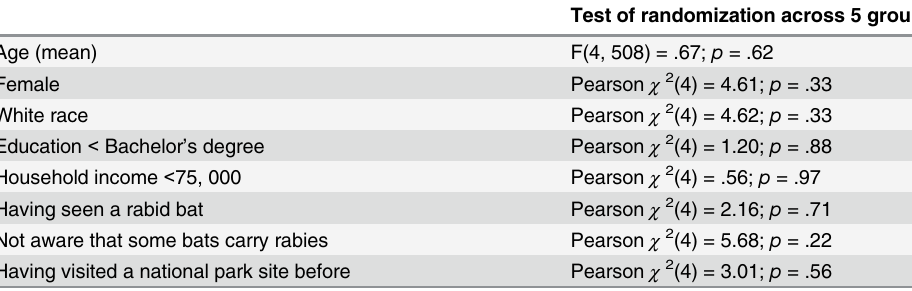
Table 1. Demographic characteristics of participants in a visitor-intercept experiment to assess responses to messages about bat rabies exposure prevention. Test of randomization across 5